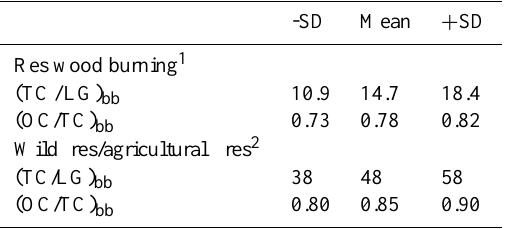
Table 2. Emission ratios (mean ± SD) used to calculate concentra- tions of EC from biomass burning (EC bb ) according to Eqs.